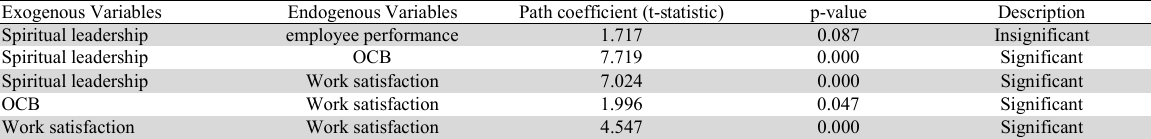
Testing Results of Direct and Indirect